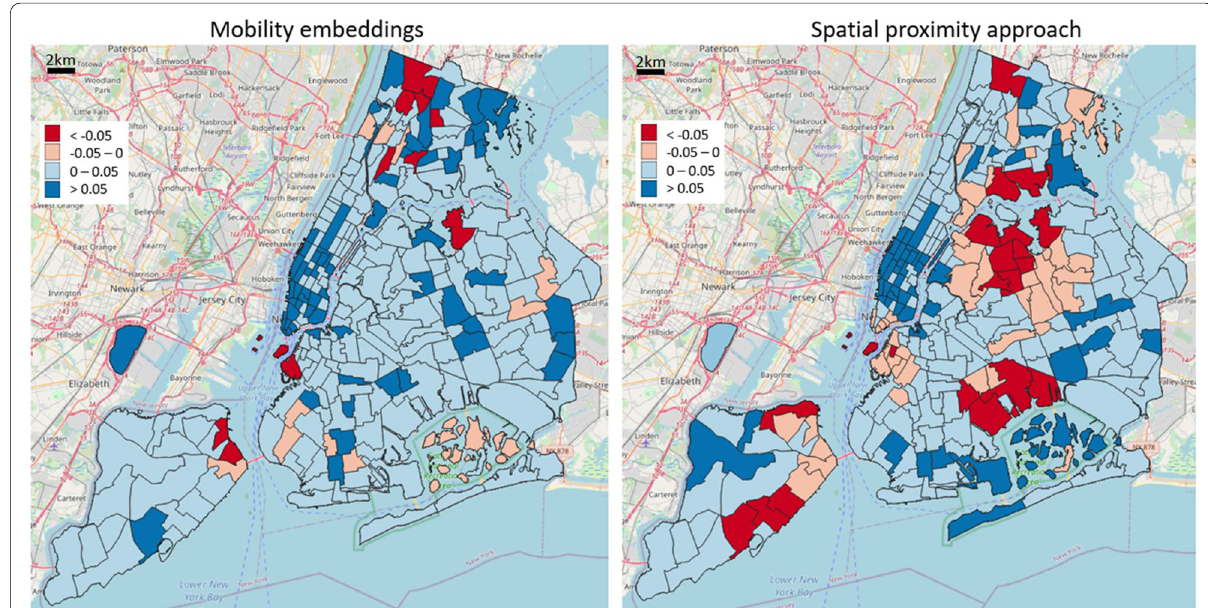
Fig. 7 Assessment of functionality cluster consistency according to residential and tourist-related functionality classes: cosine similarity difference between intra- and extra-cluster averages for each reference